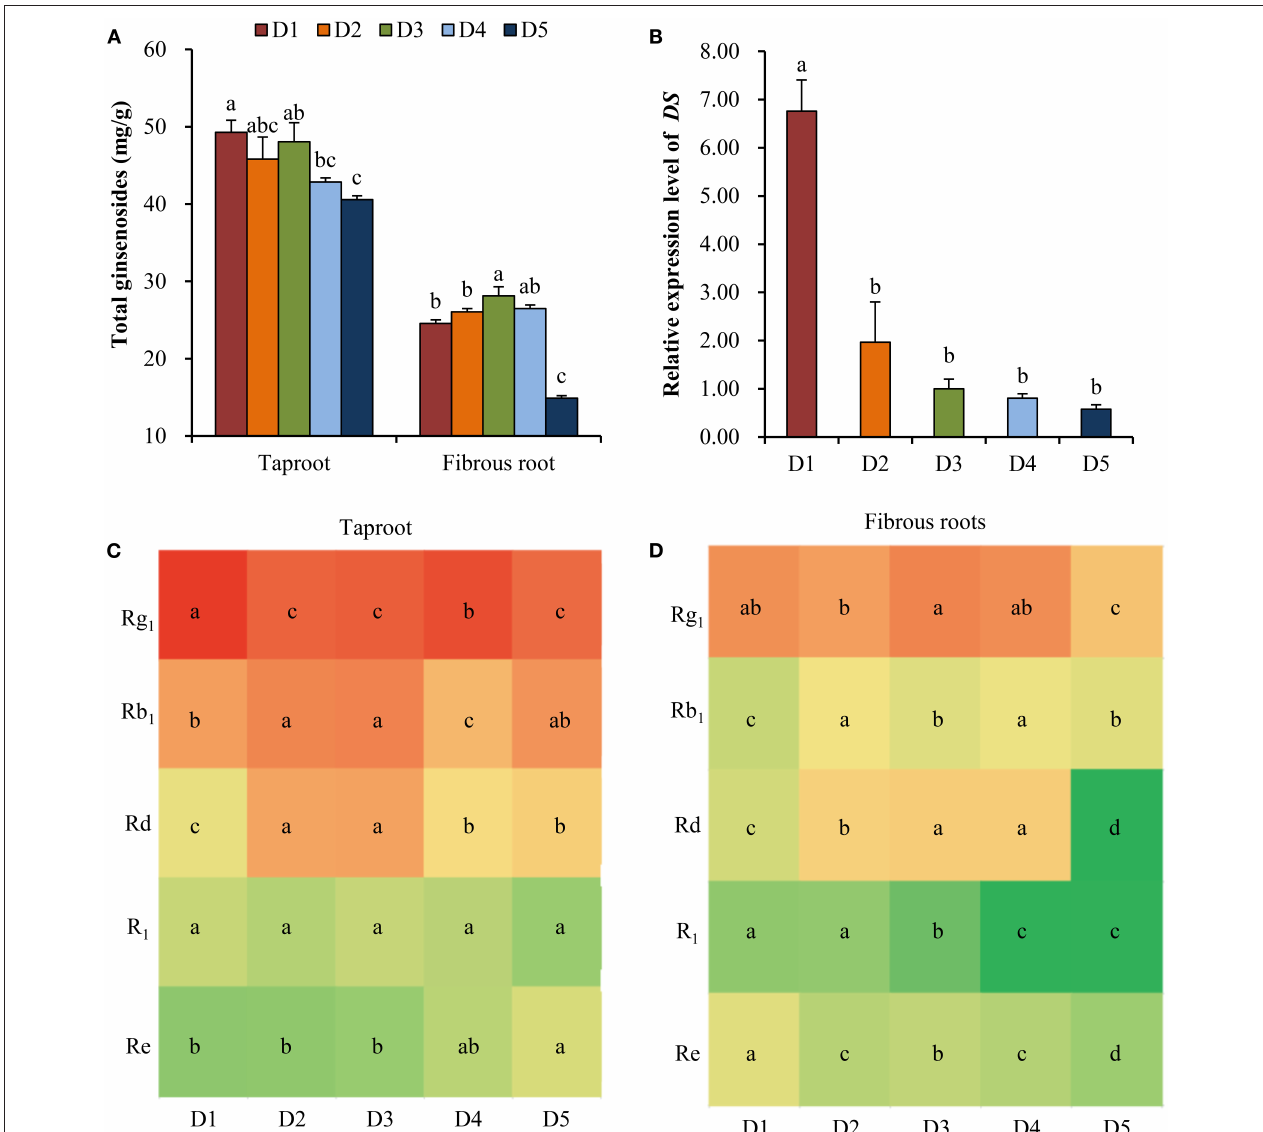
FIGURE 3 | Effects of planting densities on the content of ginsenoside and relative expression level of DS . (A) Total contents of five ginsenosides in the taproot and fibrous root. (B) Relative expression level of DS . Monomeric ginsenoside in the taproot (C) and fibrous roots (D) of P. notoginseng . D1 ∼ D5 represent densities of 8 × 8, 10 × 10, 15 × 15, 20 × 20, and 30 × 30cm, respectively. Error bars indicate the standard error (SE). Different letters indicate statistically significant differences among the five density treatments ( p < 0.05; n = 4). The different colors in (C) and (D) indicate the changes in monomer ginsenoside content in taproots and fibrous